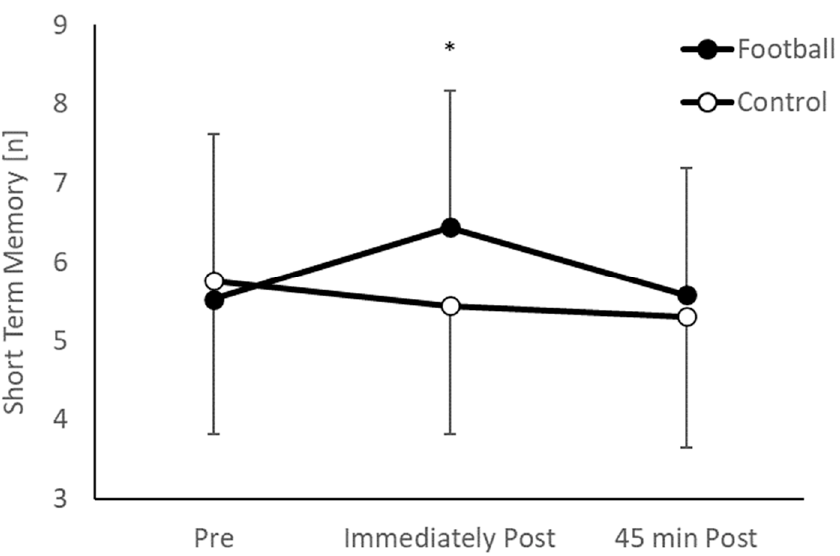
Figure 2. Short term memory performance ([n] = number of correctly recalled words) in the football and control groups across the morning (group * time interaction, p < 0.001; * football > control, p = 0.004).